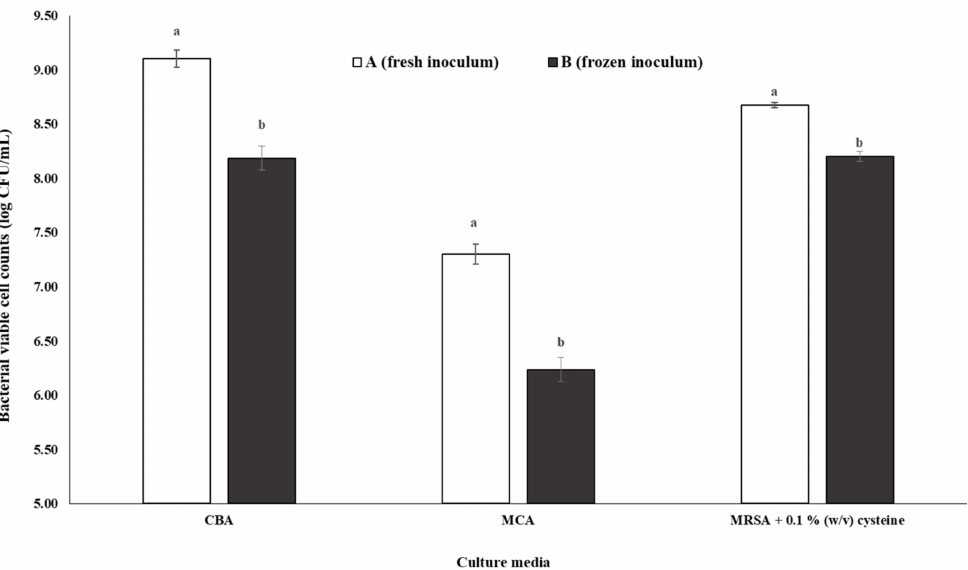
Figure 5. Bacterial viable cell counts (log CFU/mL, mean ± SD) in fresh pooled inoculum ( A ) and frozen pooled inoculum ( B ) obtained using different culture media incubated for 72 h at 37 ◦ C in anaerobic conditions. Different letters mark statically significant ( p < 0.05) differences between each condition, in each culture